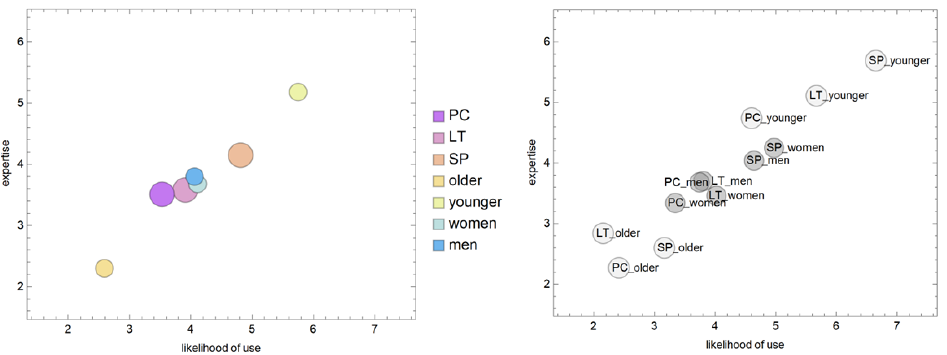
Figure 2. Overview of mean ratings from the ANOVA: for the groups ( left ); and individual ratings device_age and device_gender ( right